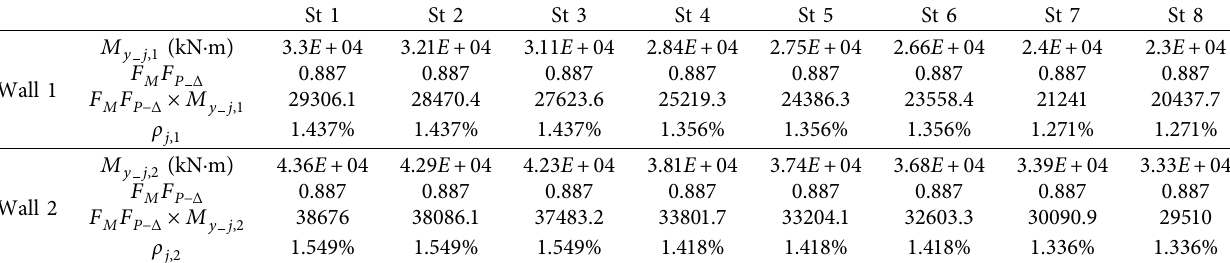
Table 12: Modifed reinforcements for stif/fexible-side walls of all storeys.